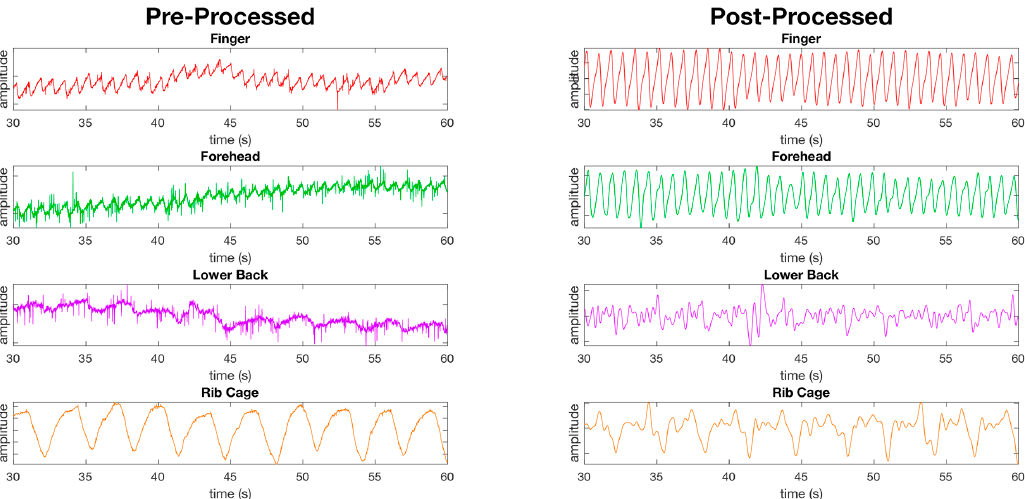
Figure 6. Figure showing the pre-processed waveforms (left) and the post-processed waveforms (right) from PPG sensors at four of the eight measurement locations using the red channel only at rest. The first two waveforms, the finger and forehead, show the success of the filters applied as detailed in the material and methods section revealing clear peaks and valleys in the waveforms. The remaining two waveforms (lower back and ribcage) show locations where the peaks and valleys are less defined post processing compared to the finger and forehead.